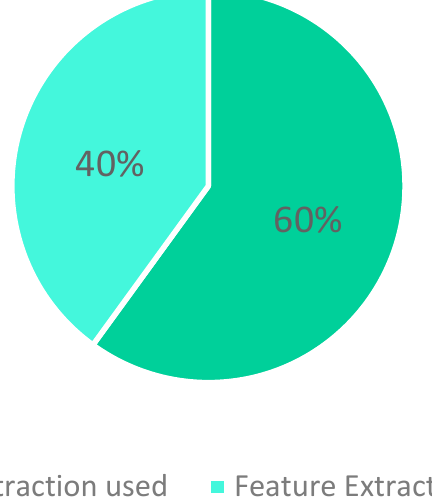
Figure 5. Feature extraction distribution (from Section 6).